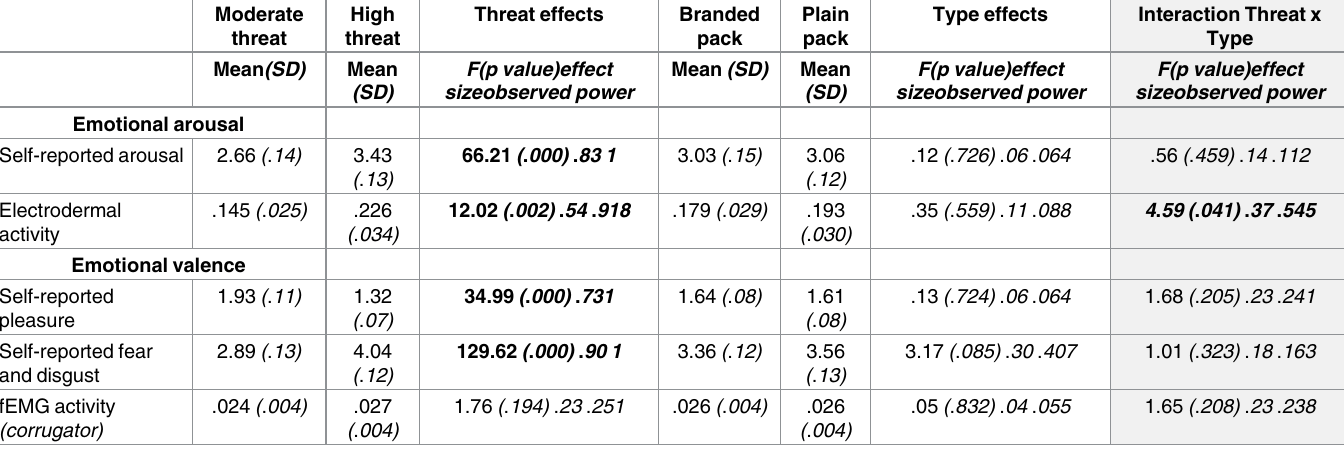
Table 1. Effects of threat level and pack type on emotional responses.